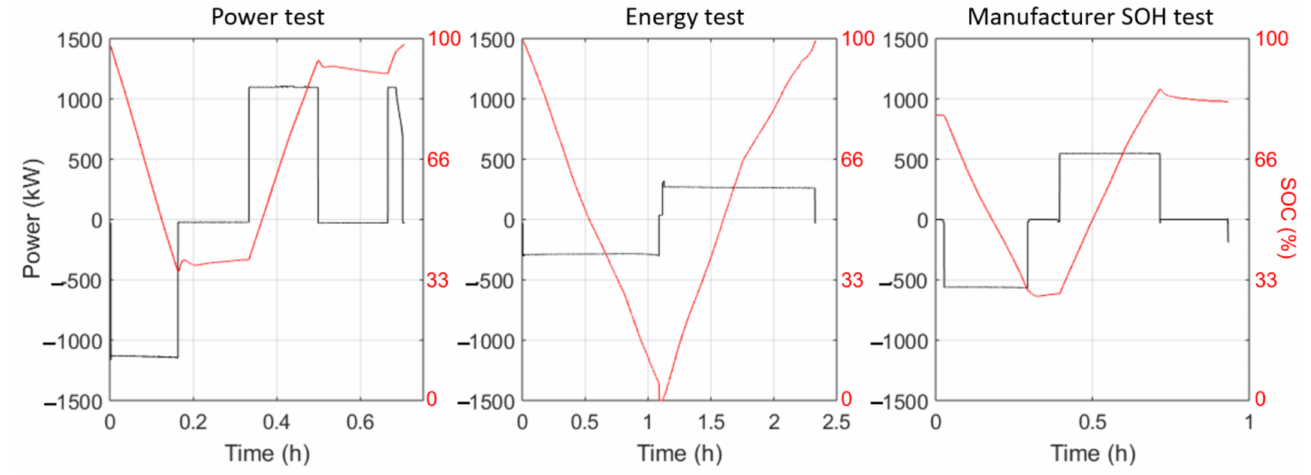
Figure 3. Example of the manufacturer tests: power, energy, and